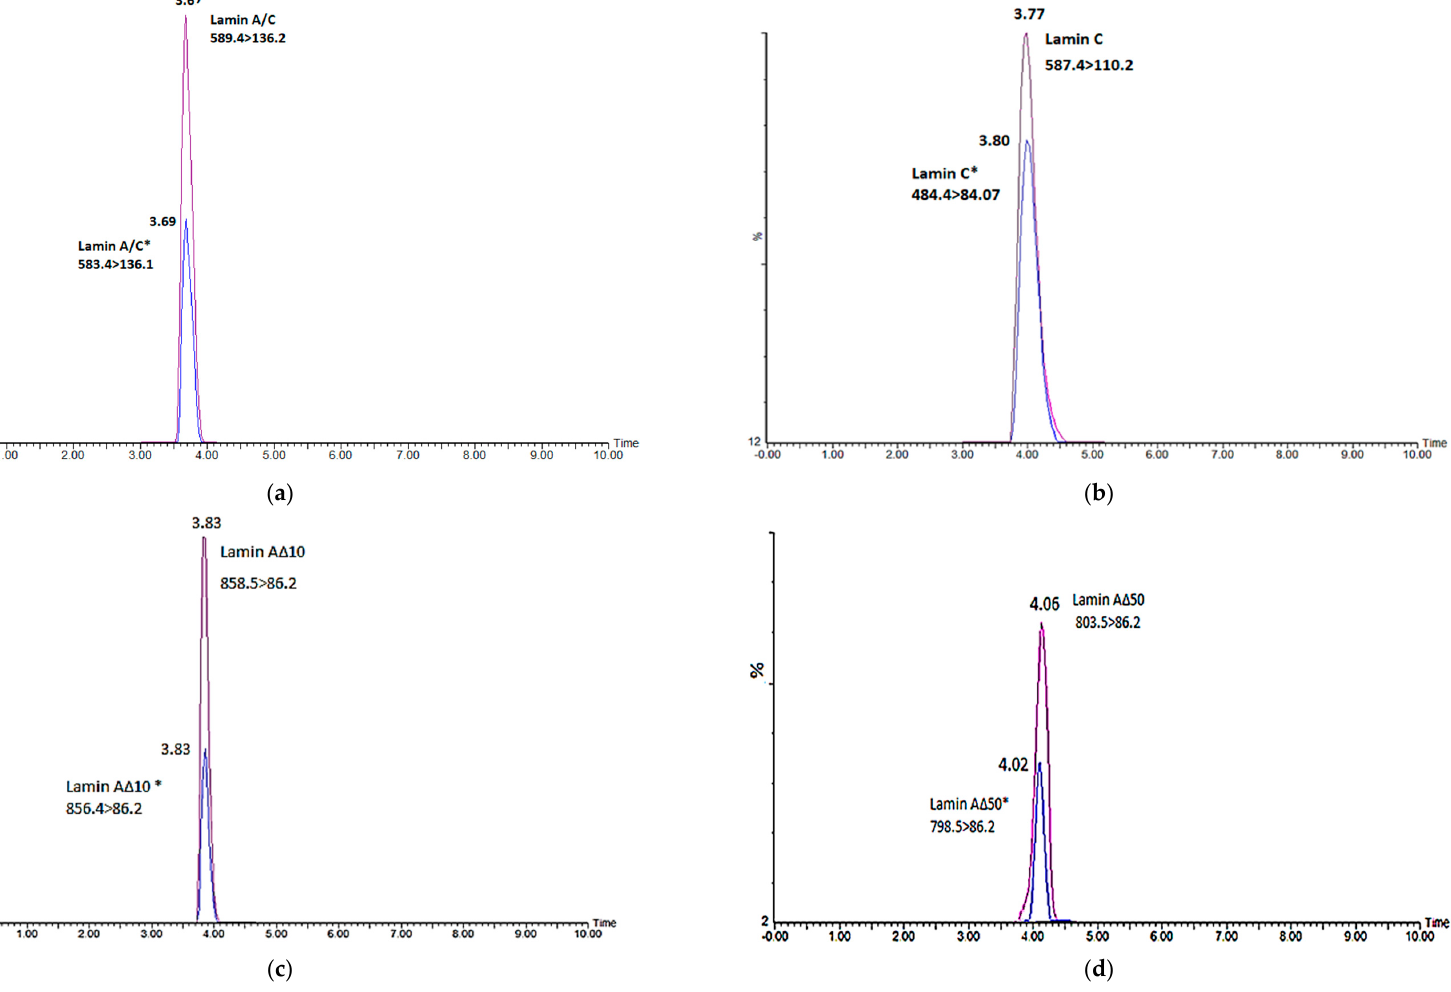
Figure 2. Chromatograms of optimized unlabeled peptides that were spiked with IS (*) at a concentration of 250 µl/mL. ( a ) Lamin A/C, ( b ) lamin C, ( c ) lamin Δ A10, ( d ) and lamin Δ A50 (Progerin).